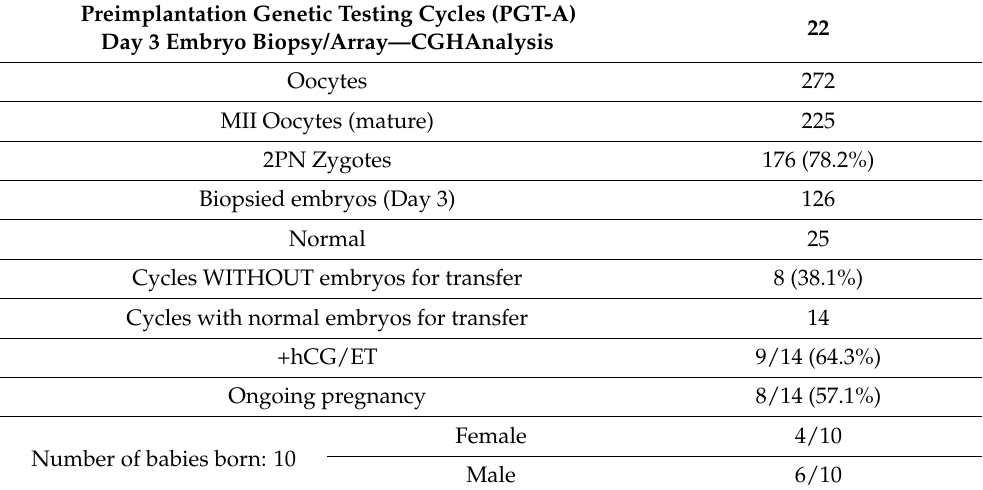
Table 2. Clinical outcome of PGT-Acycles. Preimplantation Genetic Testing Cycles